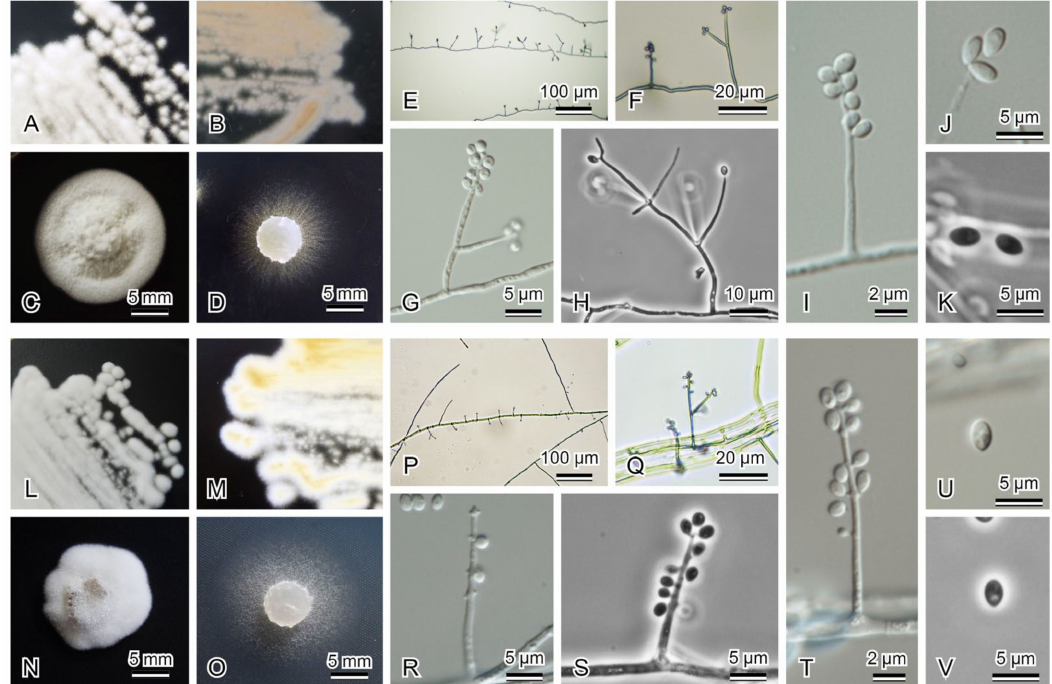
Figure 4. Simpllicillium species. ( A – K ) Simpllicillium sp. 1 aff. sympodiophorum (JCM 39230). ( A – C ) Colonies on PDA after 7 days at 25 ◦ C. ( D ) Colonies on MEA after 7 days at 25 ◦ C. ( E – I ) Conidiogenous cells. ( J , K ) Conidia. ( L – V ) Simpllicillium sp. 2 aff. sympodiophorum (JCM 39233). ( L – N ) Colonies on PDA after 7 days at 25 ◦ C. ( O ) Colonies on MEA after 7 days at 25 ◦ C. ( P – T ) Conidiogenous cells. ( U , V )